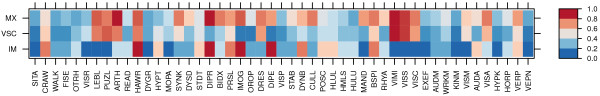
Conditional frequencies of impairment on all items.